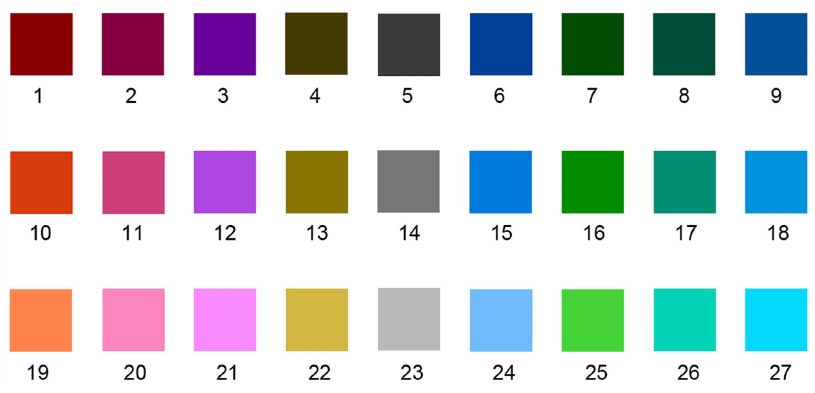
Figure 4. Experiment 1: Color samples.